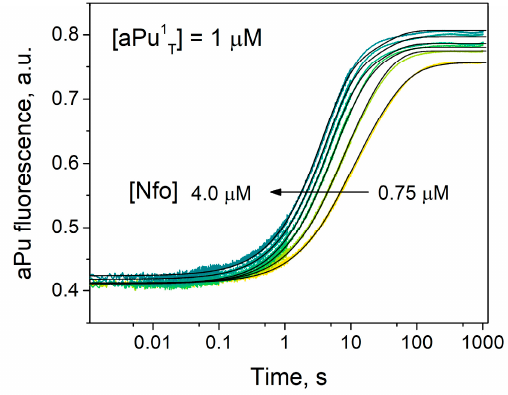
Figure 4. Alterations in the fluorescence intensity of aPu during the interaction of Nfo with aPu 1T . [aPu 1T ] = 1.0 μ M; Nfo concentration varied from 0.75 to 4.0 μ M.